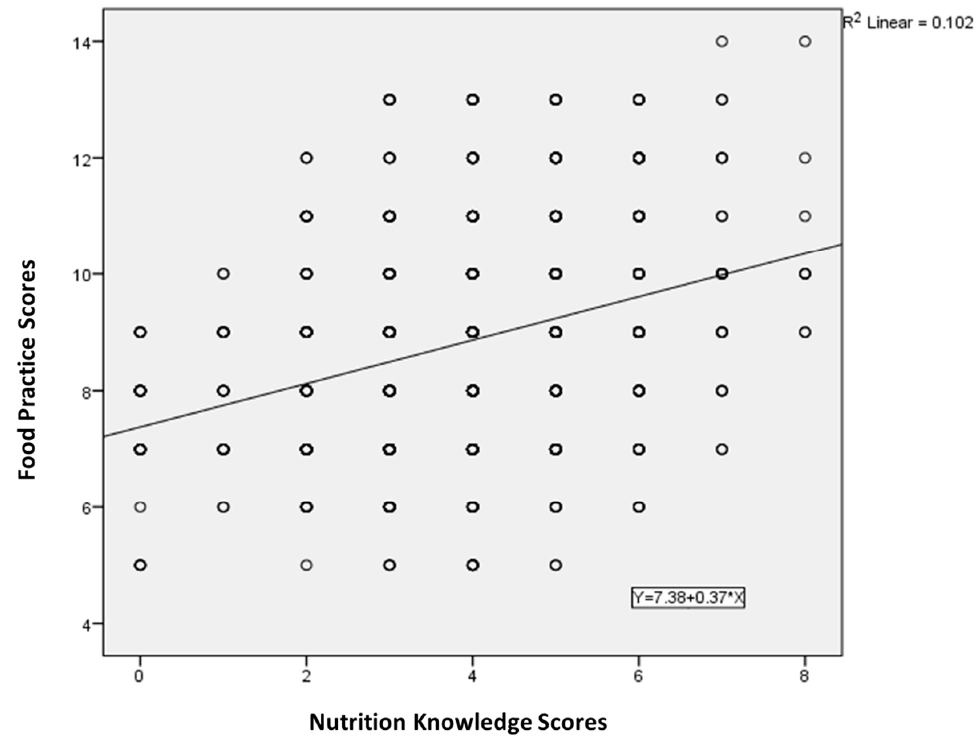
Figure 3. Relationship between nutritional knowledge score and food practice score, based on linear regression (F = 101.813, p < 0.01).